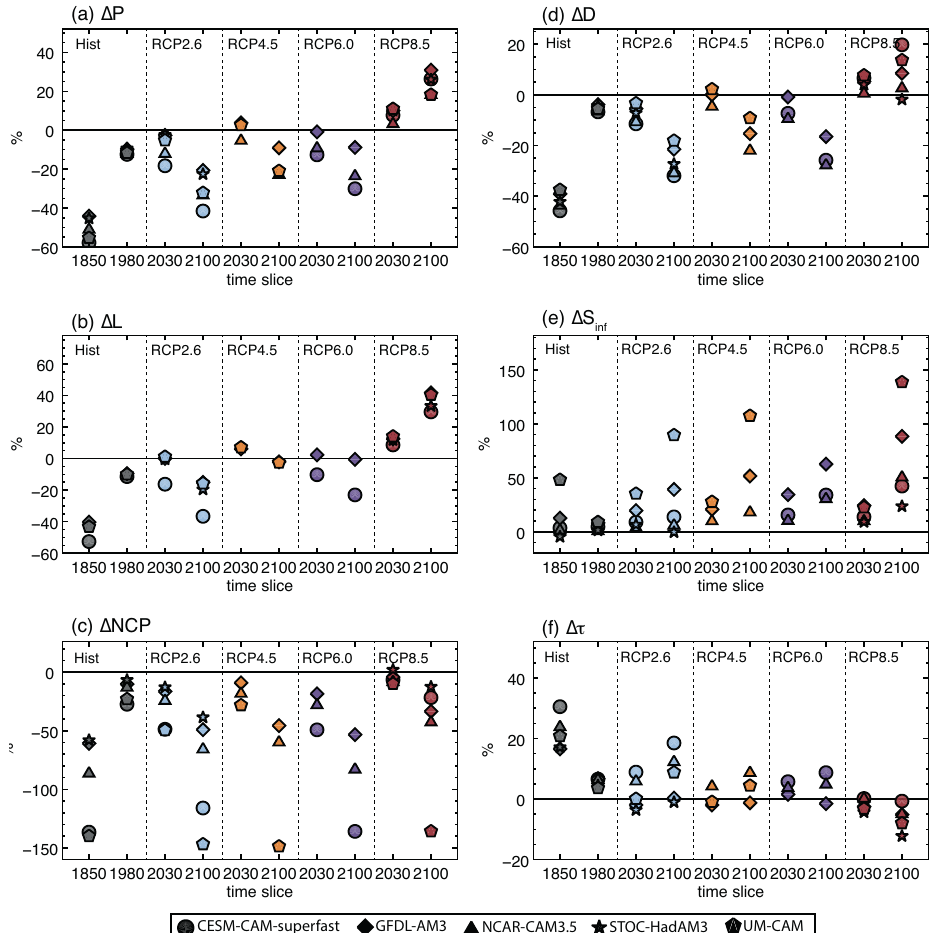
Fig. 12. Relative change in tropospheric ozone budget terms compared to Hist 2000, for all scenarios and time slices, for the subset ACCMIP models with data. Construction is similar to Fig. 7b, except the box/whisker is replaced with a symbol for each model. Relative changes are shown for (a) chemical production (P), (b) chemical loss (L), (c) net chemical production (NCP; P minus L), (d) dry deposition (D), (e) inferred stratospheric input (S inf ) and (f) lifetime ( τ